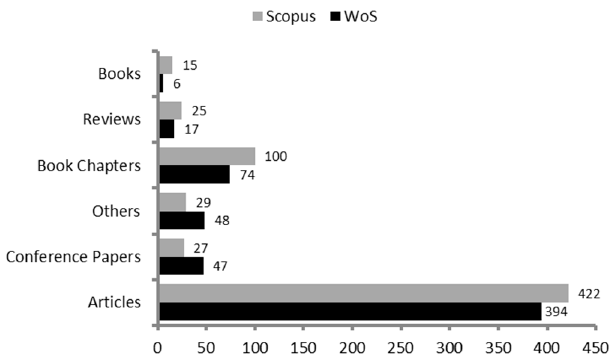
Figure 1. Types of Documents. Source: Own elaboration.